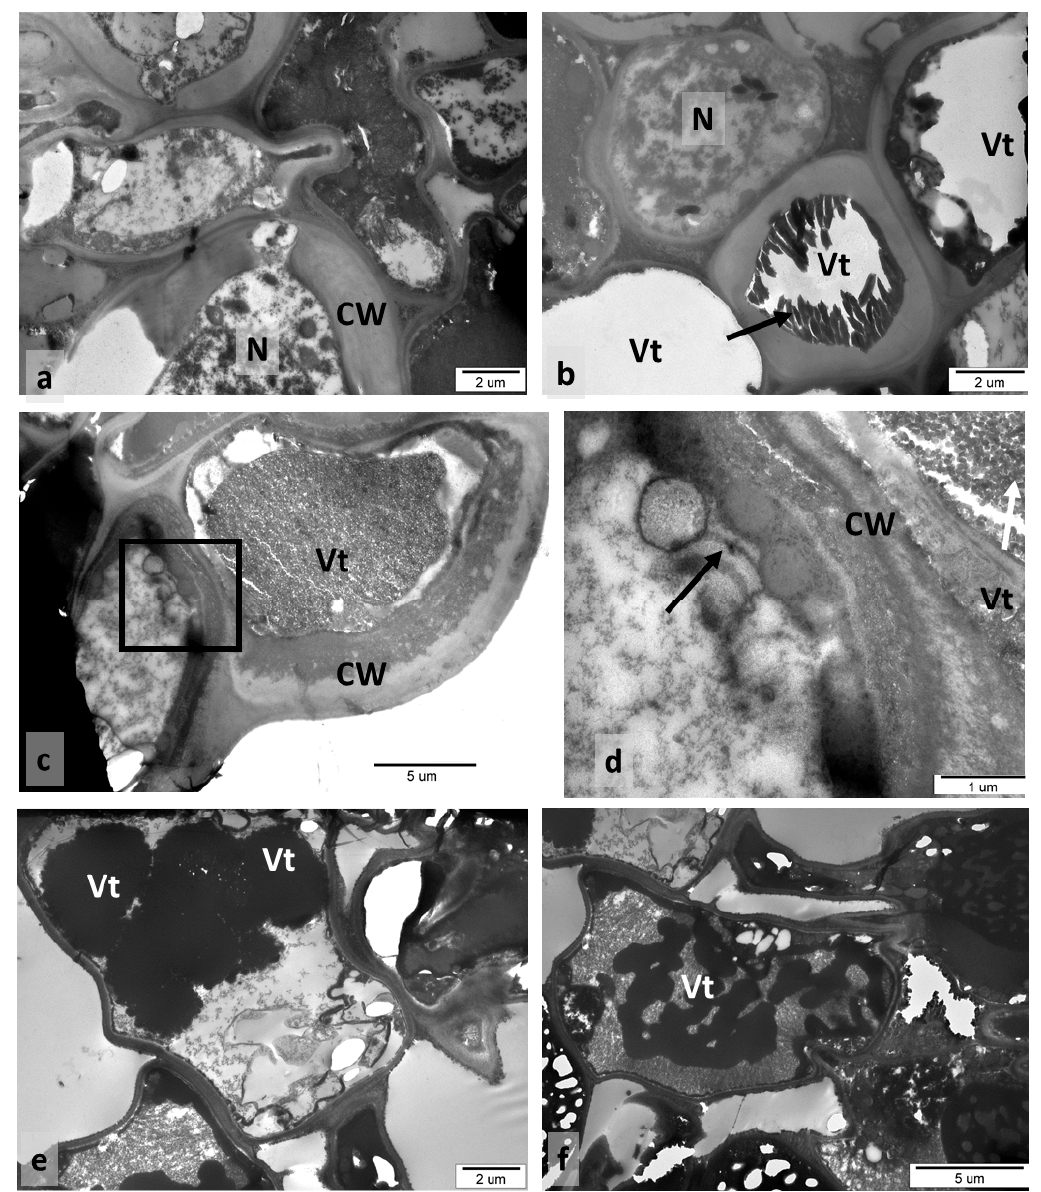
Figure 6. Autumn galls (TEM images). ( a ) Cross-section taken at border between sclerenchyma and gall parenchyma (CW, cell wall; N, nucleus). ( b ) Vt, cell tannin content of vacuoles was damaged during preparation. ( c ) Two cells of abaxial epidermis. Tannin accretions were observed in the vacuole of the larger cell and in its external cell wall. In the second cell, there was a partly visible heavy deposit of tannins in the cell wall. ( d ) Detail of previous picture. White arrow, granular structure of tannin accretions; black arrow, vesicle-like structures. ( e ) In this cell, dense tannin deposits were in each of the five vacuoles, other vacuoles without tannins. ( f ) Tannin deposits in the form of a band.